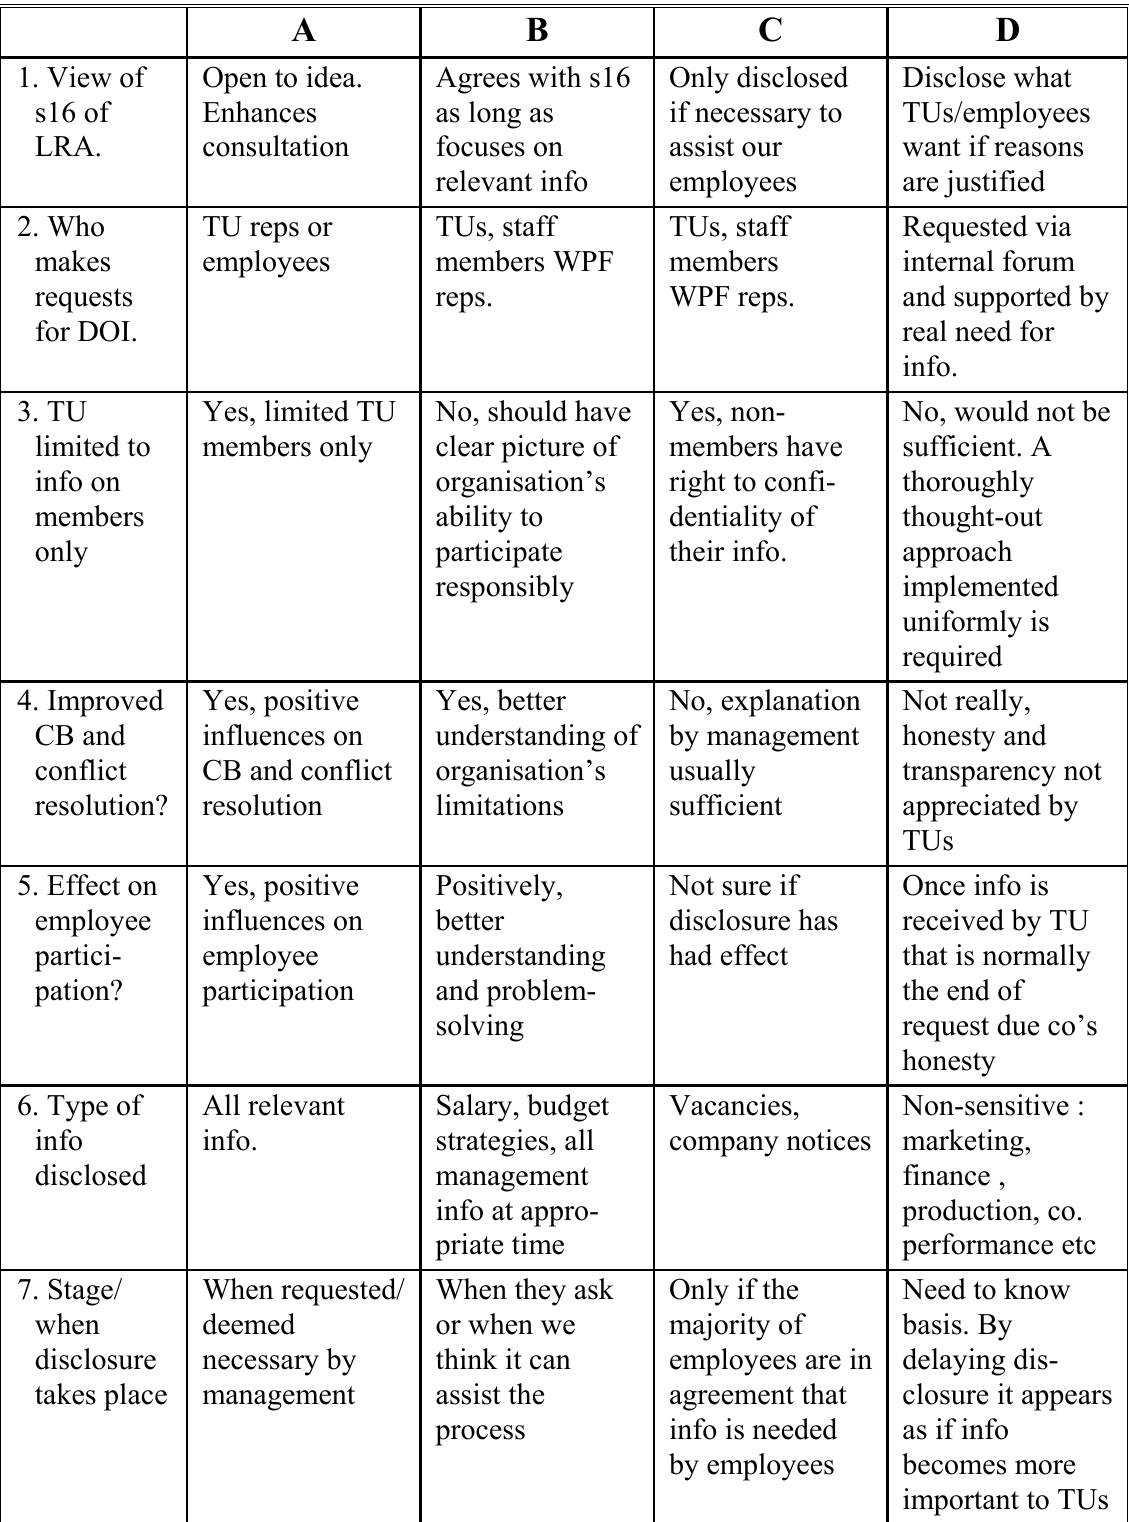
Compilation of all management representatives(cid:146) responses on disclosure of